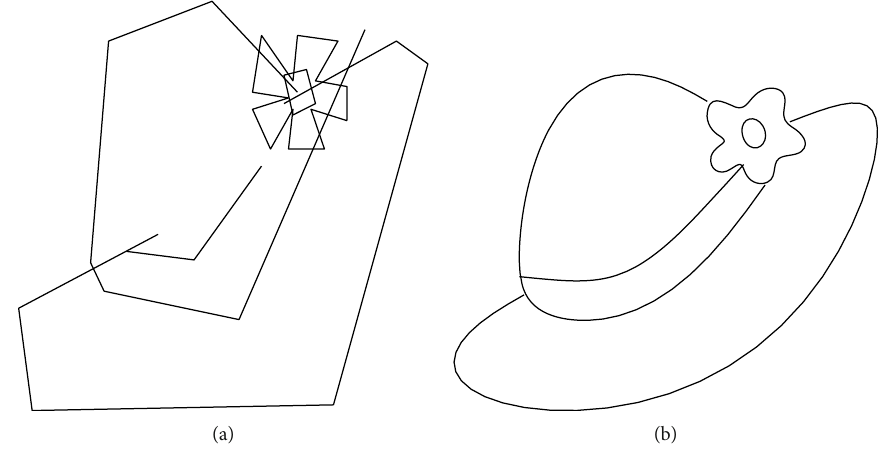
Figure 3: Application of R